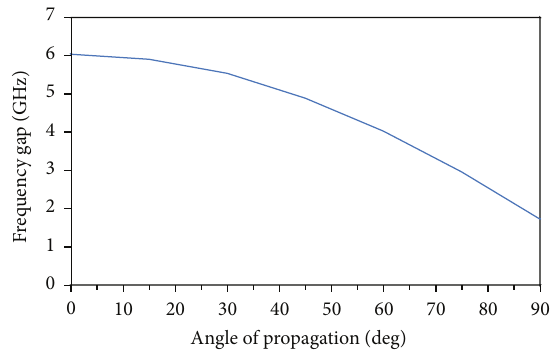
Figure 4: Frequency gap between the two spin wave bands as a function of the propagation direction. In this case SW propagation is always parallel to the applied field direction 𝜃 (defined in Figure 1). The gap decreases as a consequence of the frequency decrease of the upper band, due to the increasing of the demagnetizing field in the elongated elements of the lattice (secondary